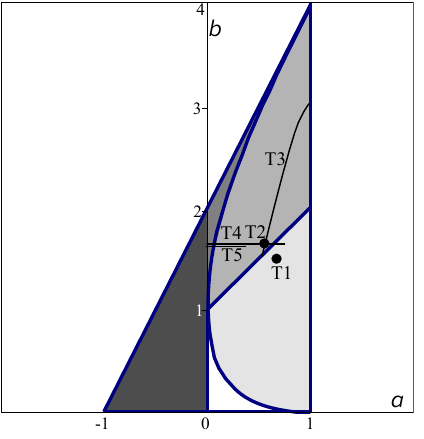
Table 1. Numerical data for the tuning of parameters c